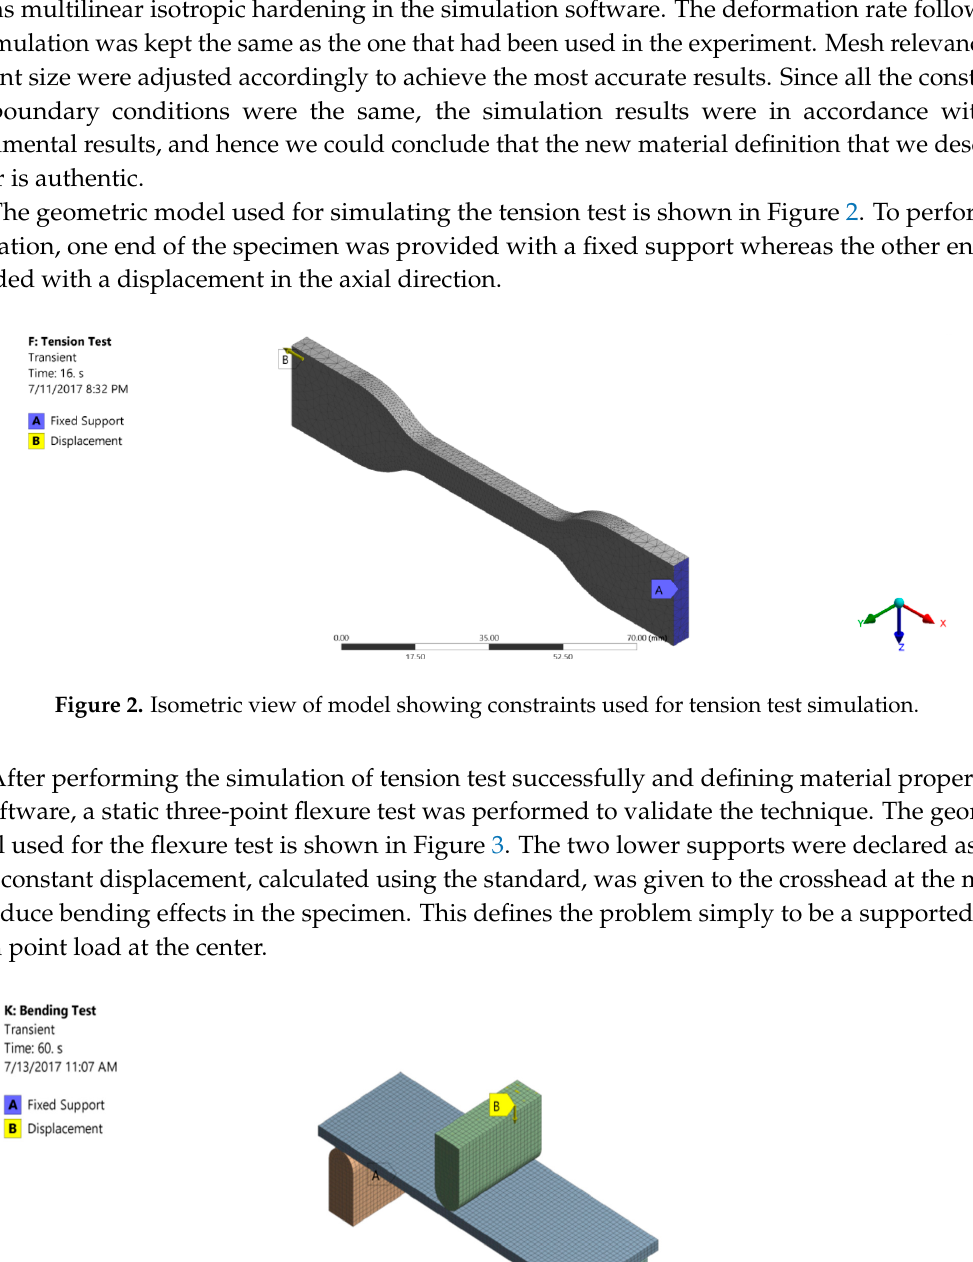
Figure 3. Isometric view of model with constraints used for the three-point flexure test simulation.